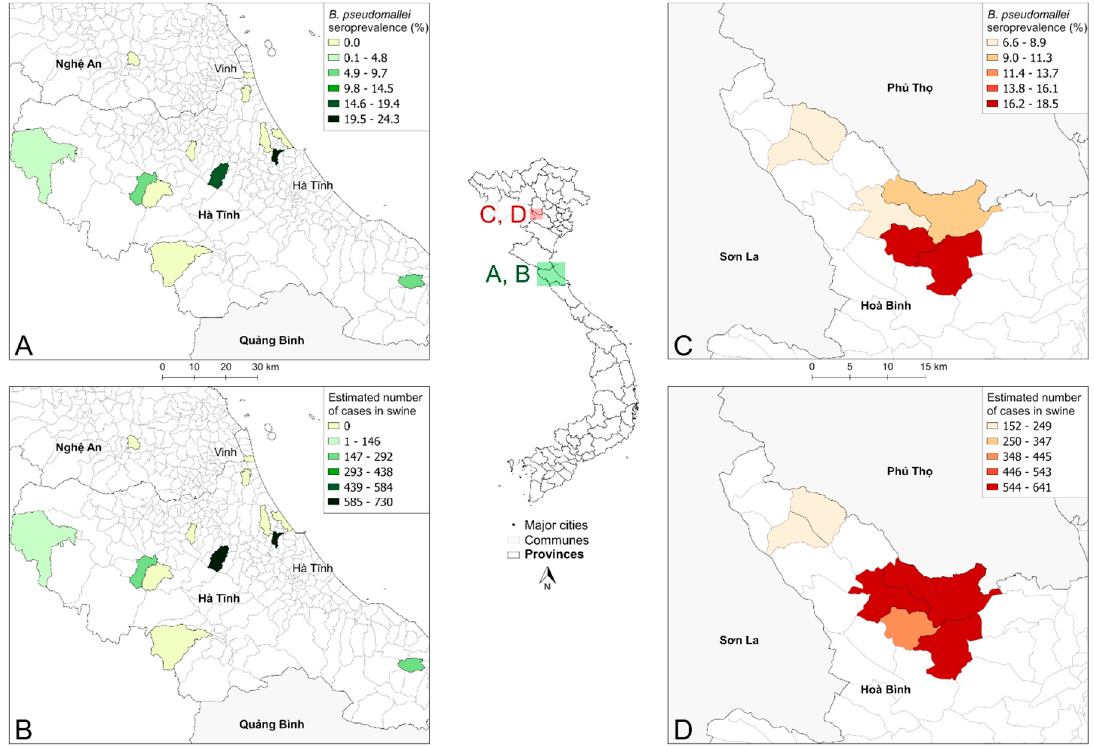
Figure 4. Estimated B. pseudomallei swine exposures in Ha Tinh, Nghe An, and Hoa Binh Provinces, Vietnam. ( A ) The seroprevalence of melioidosis in swine mapped to the communes of Ha Tinh and Nghe An Provinces. ( B ) The estimated number of total seropositive animals in the sampled communes in Ha Tinh and Nghe An. ( C ) Seroprevalence of melioidosis in swine in the six communes tested in Hoa Binh Province. ( D ) The estimated number of total seropositive animals in the sampled communes in Hoa Binh Province. Inset map identifies the locations of panels A–D within Vietnam.